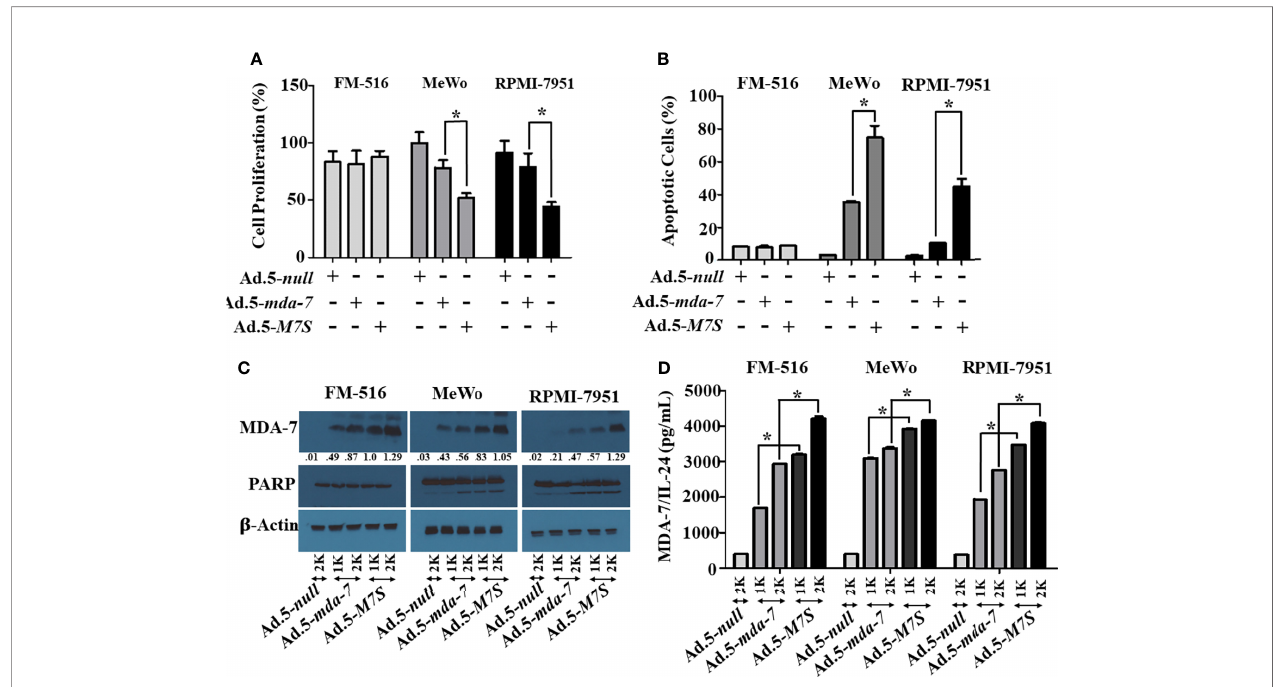
FIGURE 2 | Ad.5- M7S suppresses proliferation and induces apoptosis of melanoma cells more robustly than wild type Ad.5- mda-7. (A, B) Immortal primary melanocytes (FM-516) and melanoma cell lines (MeWo and RPMI-7951) were infected with Ads expressing either mda-7/IL-24 or M7S at different m.o.i. After 72 hr., cell proliferation (A) and apoptosis (B) were determined by MTT assay and Flowcytometry (Annexin-V/PI- staining), respectively. (C) Western blotting analysis was performed to determine intracellular MDA-7/IL-24 protein levels and PARP cleavage (an indicator of apoptosis). Actin was used as a loading control. Values underneath the blot represent fold-changes in densitometry for MDA-7/IL-24 protein levels using actin as a control. (D) Secretion of MDA-7/IL-24 was determined in infected cell-derived CM using MDA-7/IL-24-speci fi c ELISA. *Statistical signi fi cance (p<0.05). Different virus dose indicated as viral particles (VP): 1K: 1000 VP; 2K: 2000